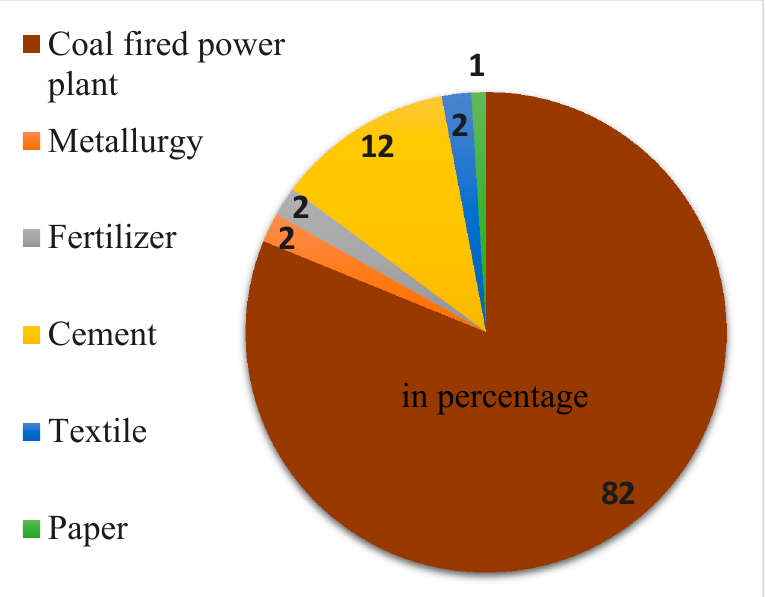
Figure 2. Shares of domestic coal consumption in Indonesia in 2016.